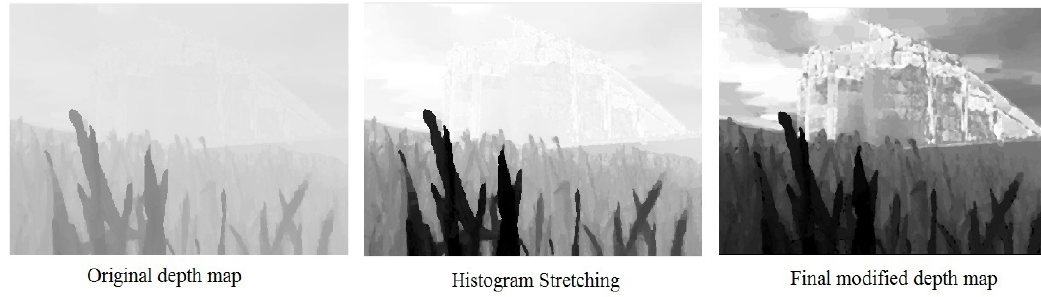
Figure 5. Steps of modifying the depth map.